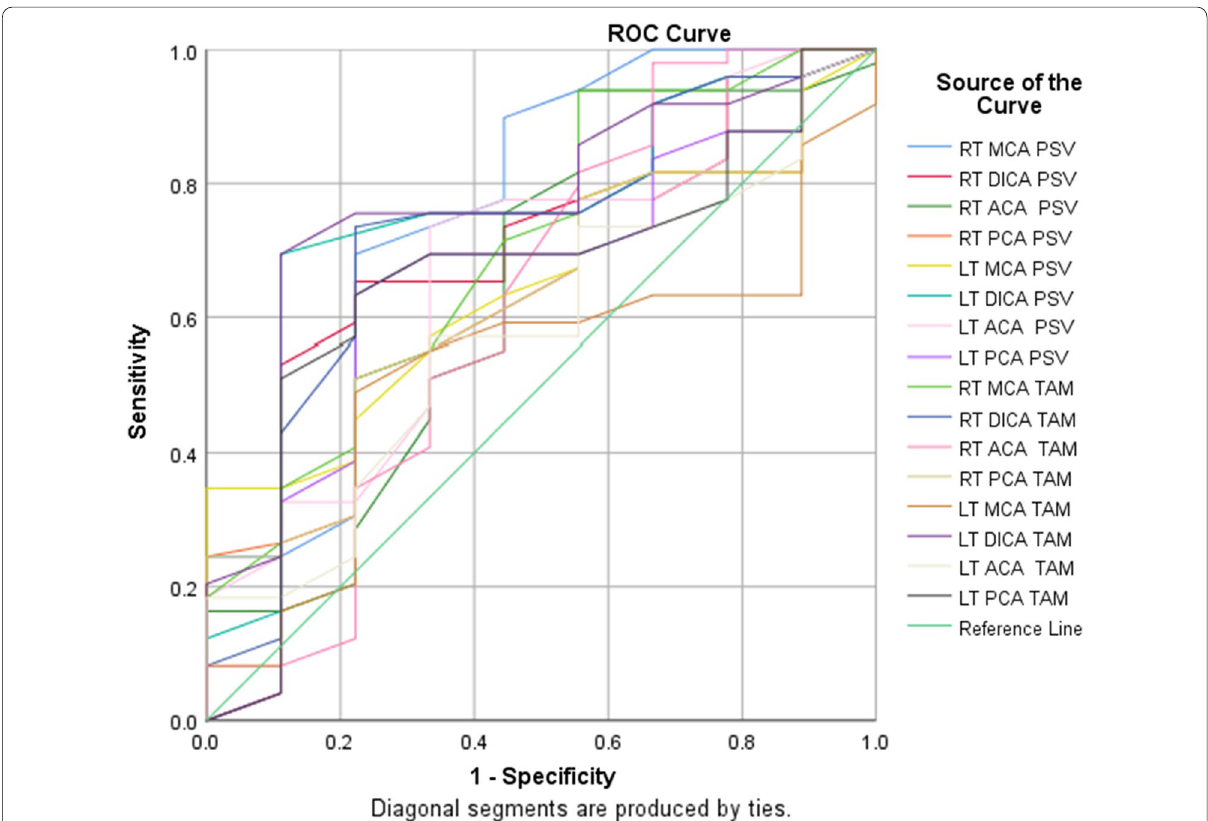
Fig. 5 ROC curve for specificity and sensitivity between TCA Doppler and need for